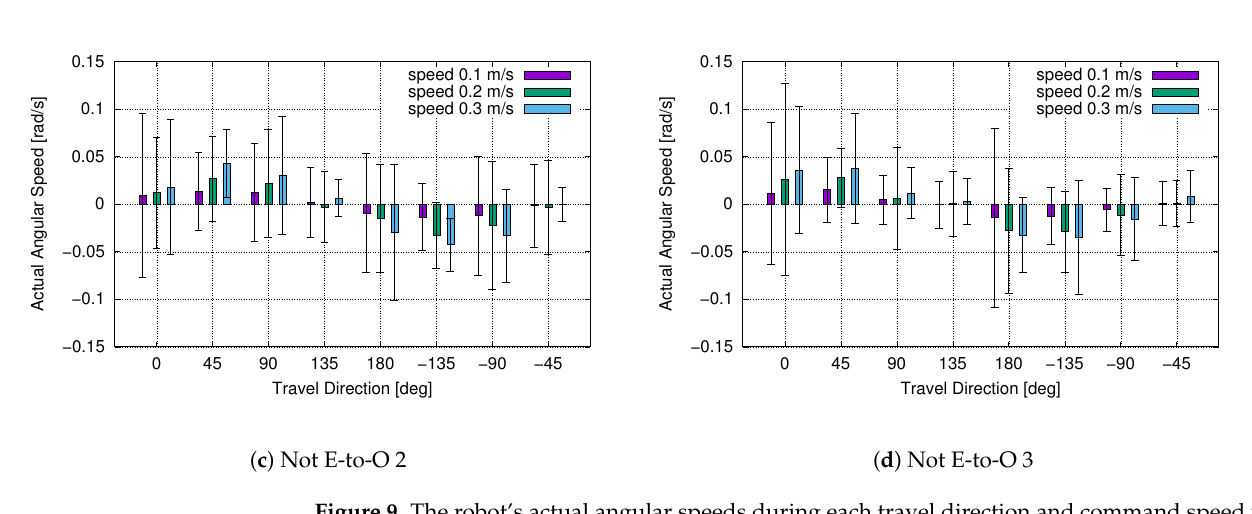
Figure 9. The robot’s actual angular speeds during each travel direction and command speed with 4-wheeled Omni wheel robots.